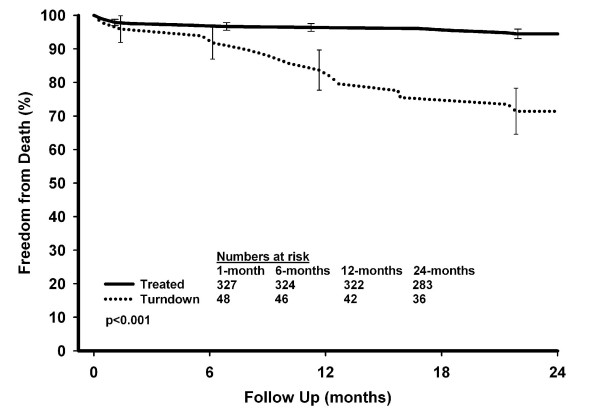
Observed survival.